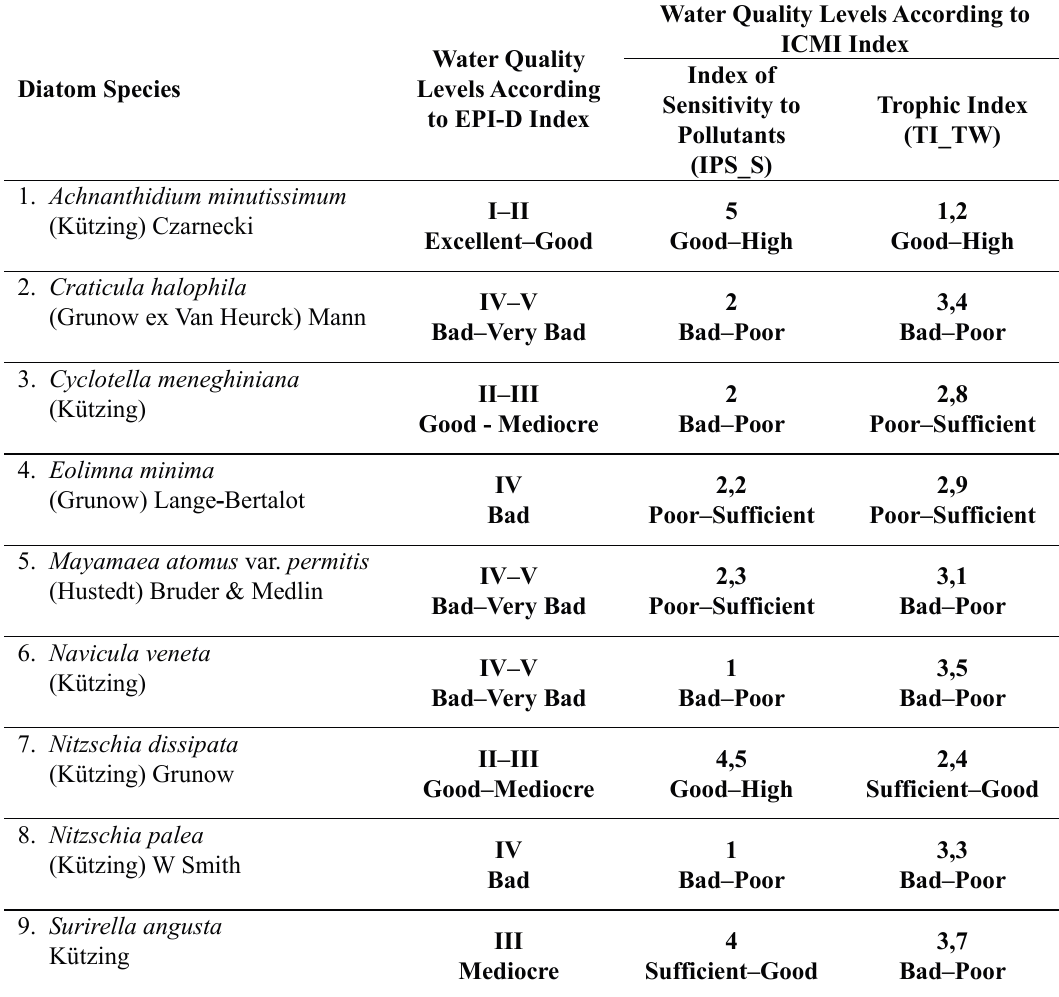
Table 1. Panel of nine diatom species and their correlation with water quality levels.